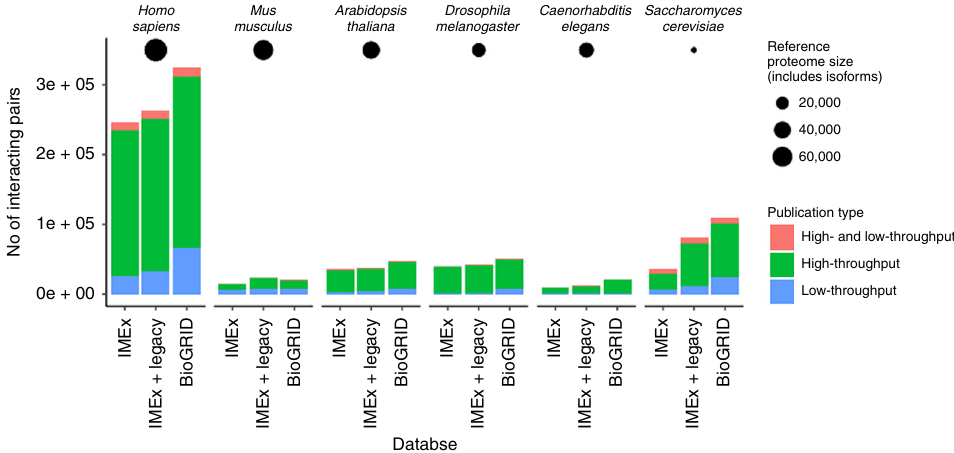
Fig. 2 Number of unique interacting pairs in selected model organisms present in interaction databases. Differently coloured bars indicate the type of studies from which the data were curated. Data were accessed in January